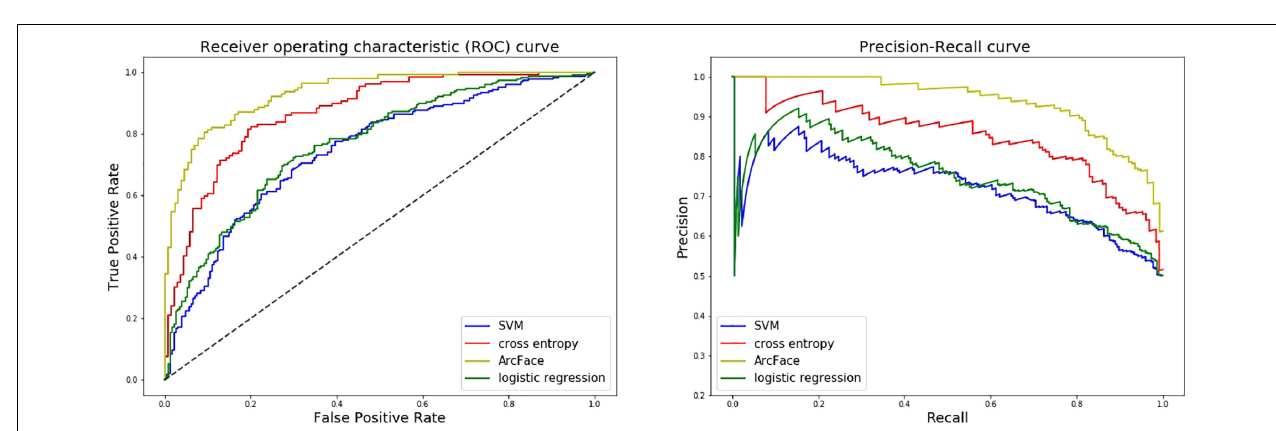
FIGURE 6 | ROC curves and P–R curves of four different models when distinguishing children with Noonan syndrome from healthy children. The DCNN-Arcface model is consistently better than the other three.